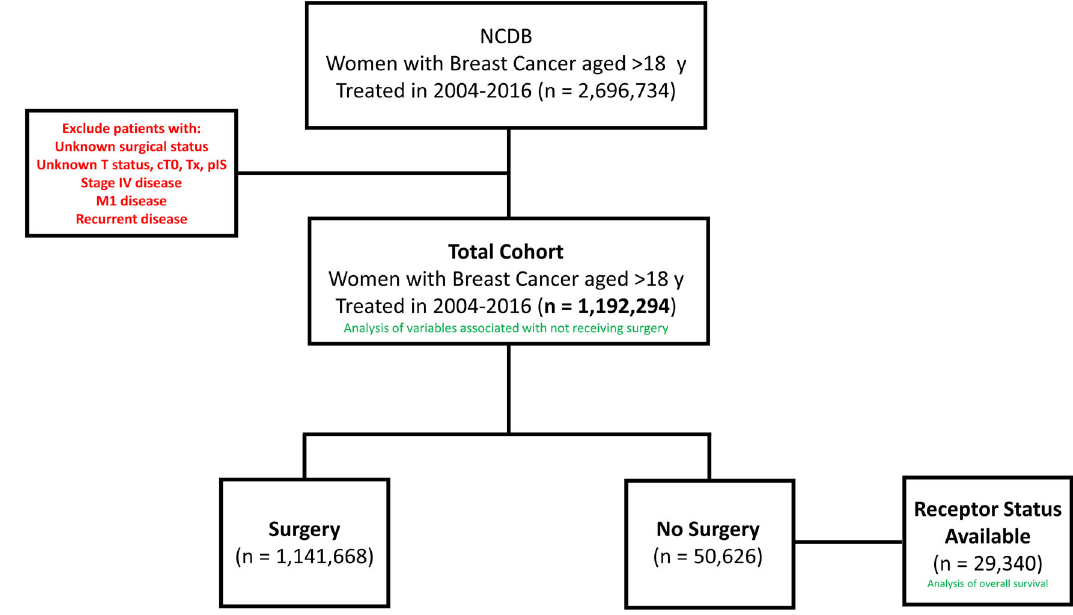
Fig. 1 CONSORT diagram. Total screened population, exclusion criteria (red), total analyzed cohort, and the overall survival analysis subcohort with available receptor status are